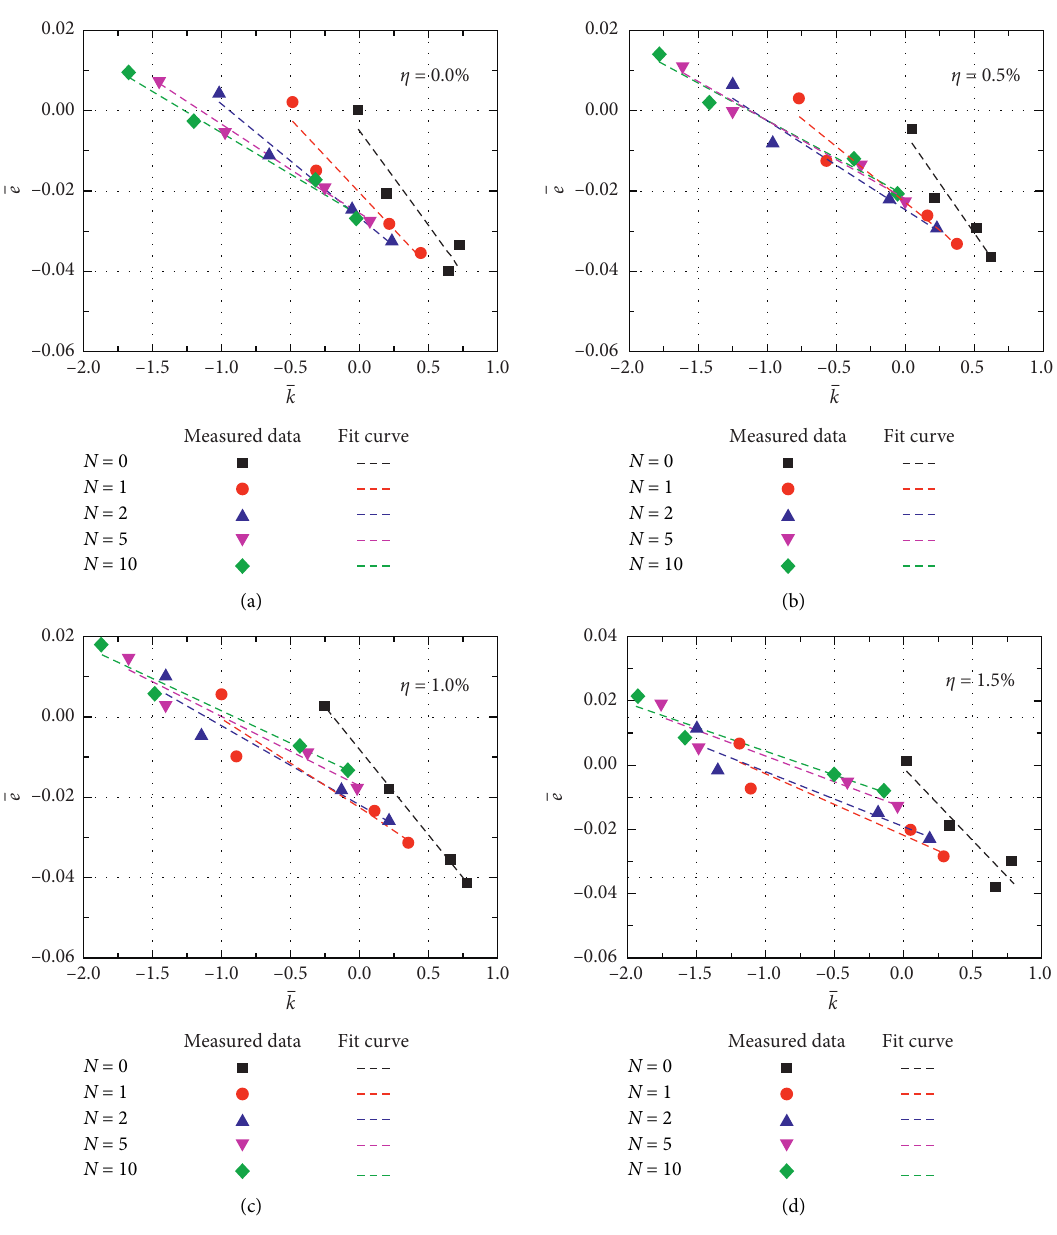
Figure 9: Relationship between e and k